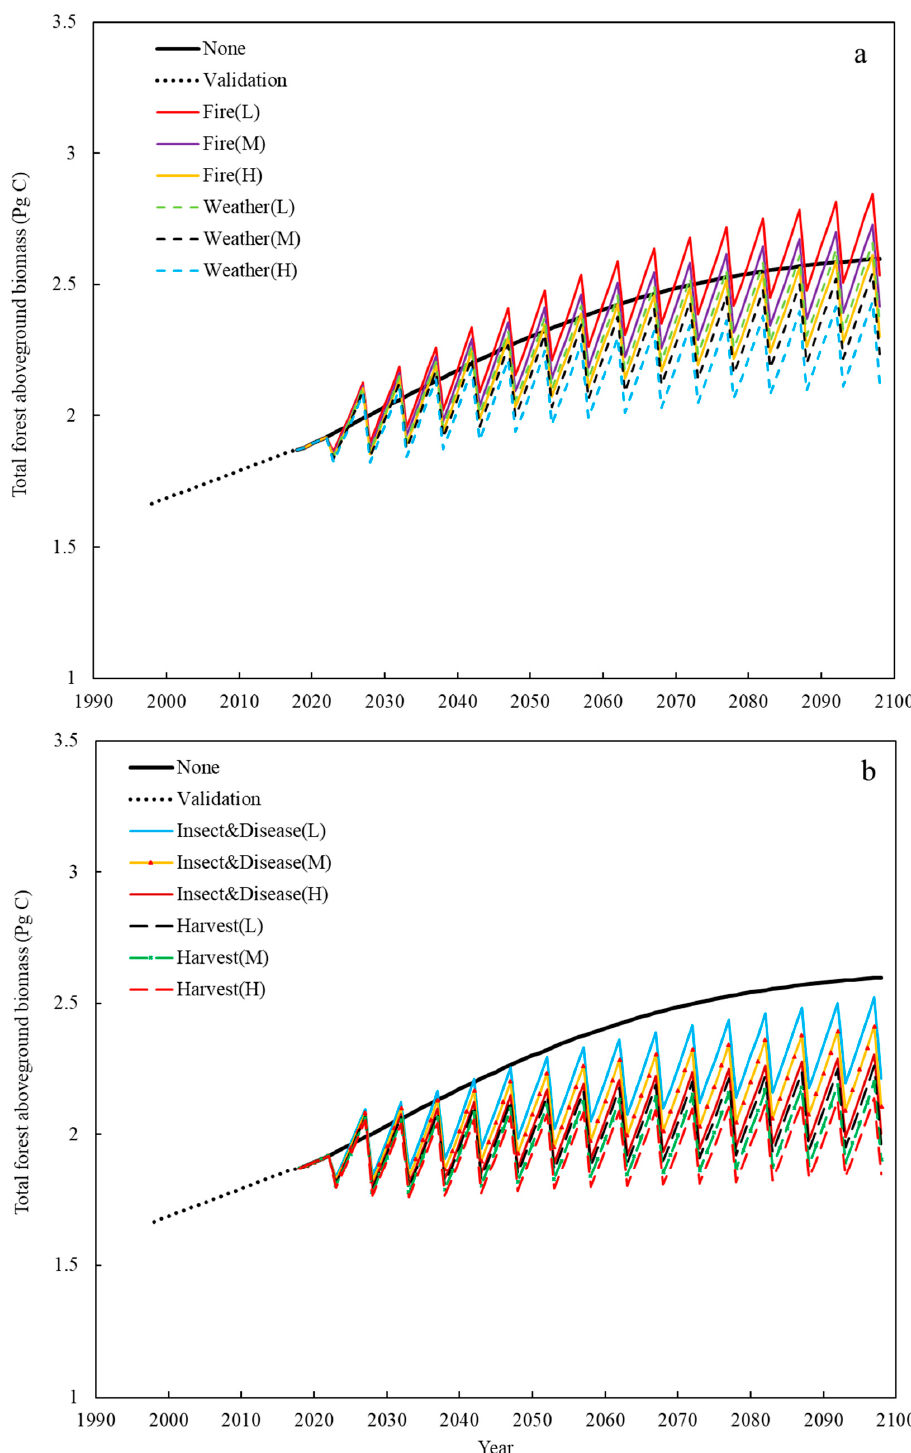
Figure 5. Predicted total forest aboveground biomass (Pg C) by matrix growth models from 1998 to 2098 under disturbances including fire and weather ( a ) and insect & disease and harvest ( b ) with low (L), medium (M), and high (H) severity in the Northern US. Disturbances included fire, weather, insect and disease, and harvest. None and validation represent forests that naturally grow without considering LUC and